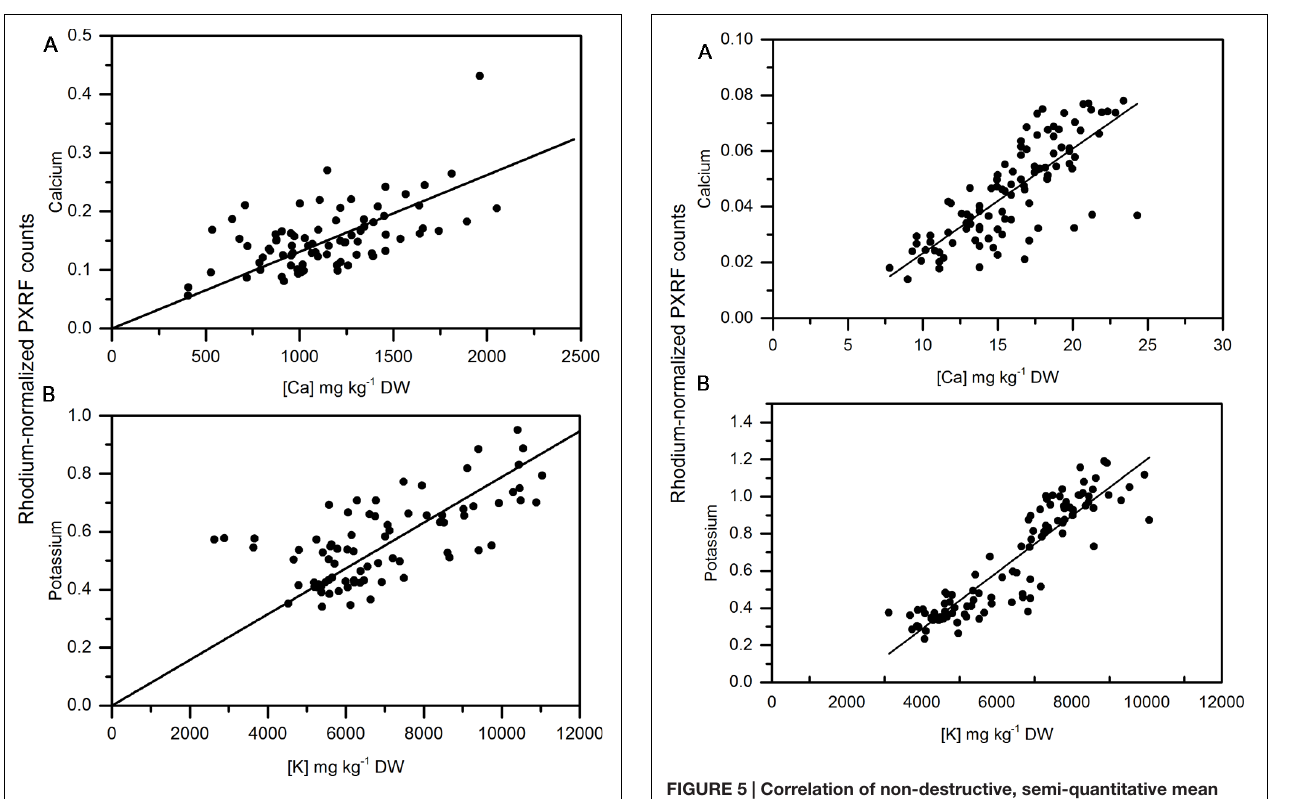
FIGURE 4 | Correlation of non-destructive, semi-quantitative mean (A) calcium and (B) potassium content compared to corresponding MP-AES analysis of calcium in pear peel ( N = 80).